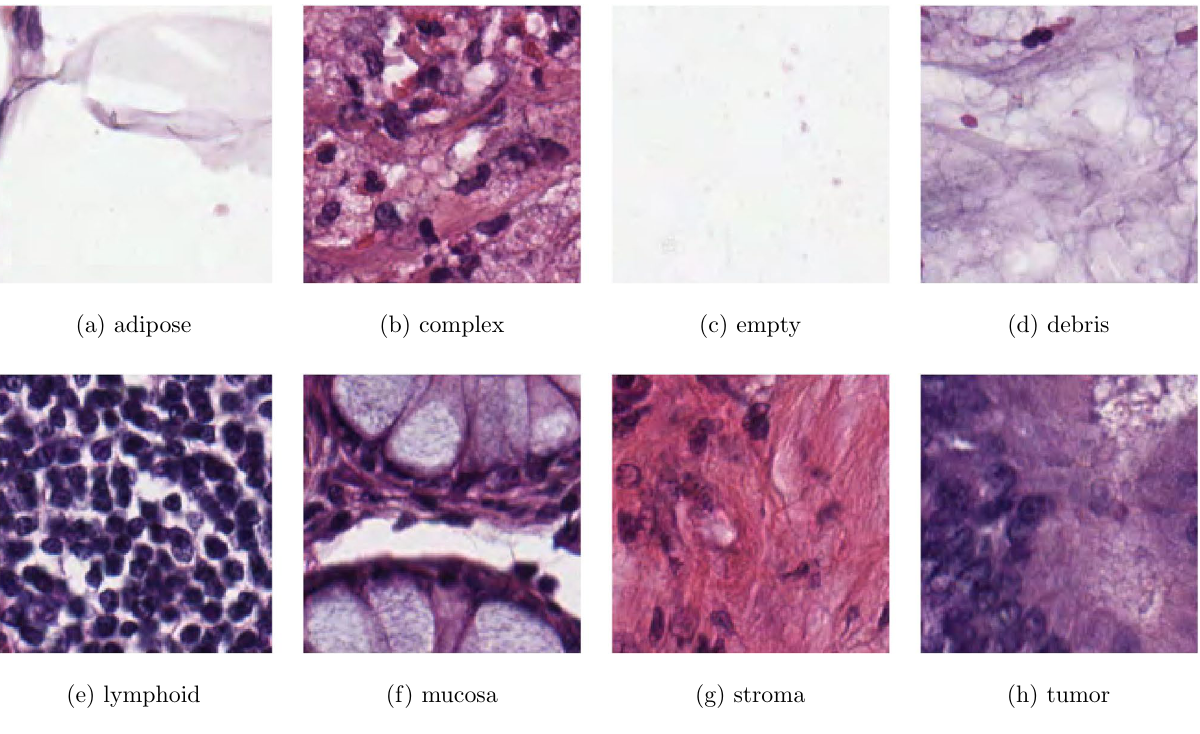
Figure 1. H&E stained tissue images of colorectal